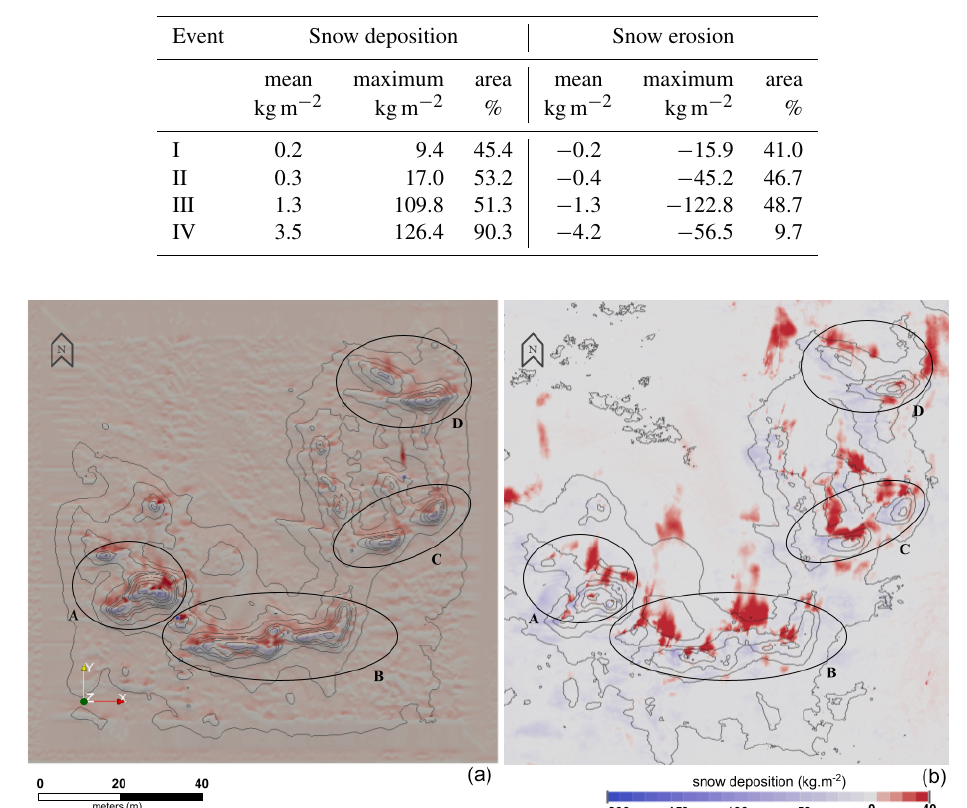
Figure 6. (a) Numerical snow deposition patterns (kgm − 2 ) after the combination of the extrapolated snowBedFoam 1.0. simulation results from the four individual atmospheric events (I–IV). (b) Snow mass differences obtained by differencing two successive elevation models measured during